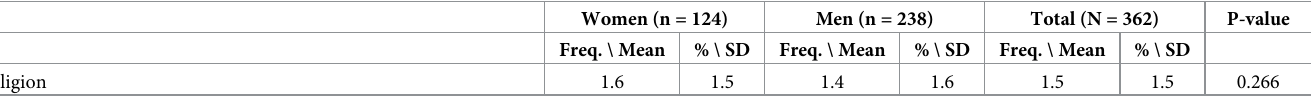
as a coping strategy (B = -1.08, 95% CI: -1.34 –-0.82). Depression level was positively associated with internalized HIV/AIDS stigma (B = 0.61, 95% CI: 0.12–1.11), availability of instrumental support from others (B = 0.03, 95% CI: 0.01–0.04), and frequency of using behavioral dis- engagement as a coping strategy (B = 0.43, 95% CI: 0.22–0.65). Among the coping strategies, self-distraction was associated with lower depression levels and behavioral disengagement was associated with higher depression levels. Specifically, for every one-unit increase on the COPE self-distraction scale (range 0–6), depression level decreased by 1.08 points, whereas for every one-unit increase on the COPE behavioral dis- engagement scale (range 0–6), depression level increased by 0.43 points. For every one-unit increase in internalized HIV/AIDS stigma, depression level increased by 0.61 points. For every 10-point increase in perceived availability of emotional support (range 0–100), depression level decreased by 0.06 points, and for every 10-point increase in perceived availability of instrumental support, depression level increased by 0.03 points. Two of the three hypothesized interactions based on the gendered stress process model were significantly associated with depression level. The significant interactions were gender X frequency of coping by drawing on instrumental support X income (B = 0.02, 95% CI: 0.01– 0.03) and gender X partner status X age (B = -0.22, 95% CI: -0.37 –-0.07). The interaction of gender X partner status X internalized HIV/AIDS stigma was tested but was not significantly associated with depression level (B = 0.01, 95% CI: -0.74–0.77, p = 0.973), so it was not included in Tables 2 and 3. These results support the hypotheses that gender disparities in depression are created and maintained by women’s lower social status and access to resources, but not the hypothesis regarding gender differences in exposure to stigma as a stressor.